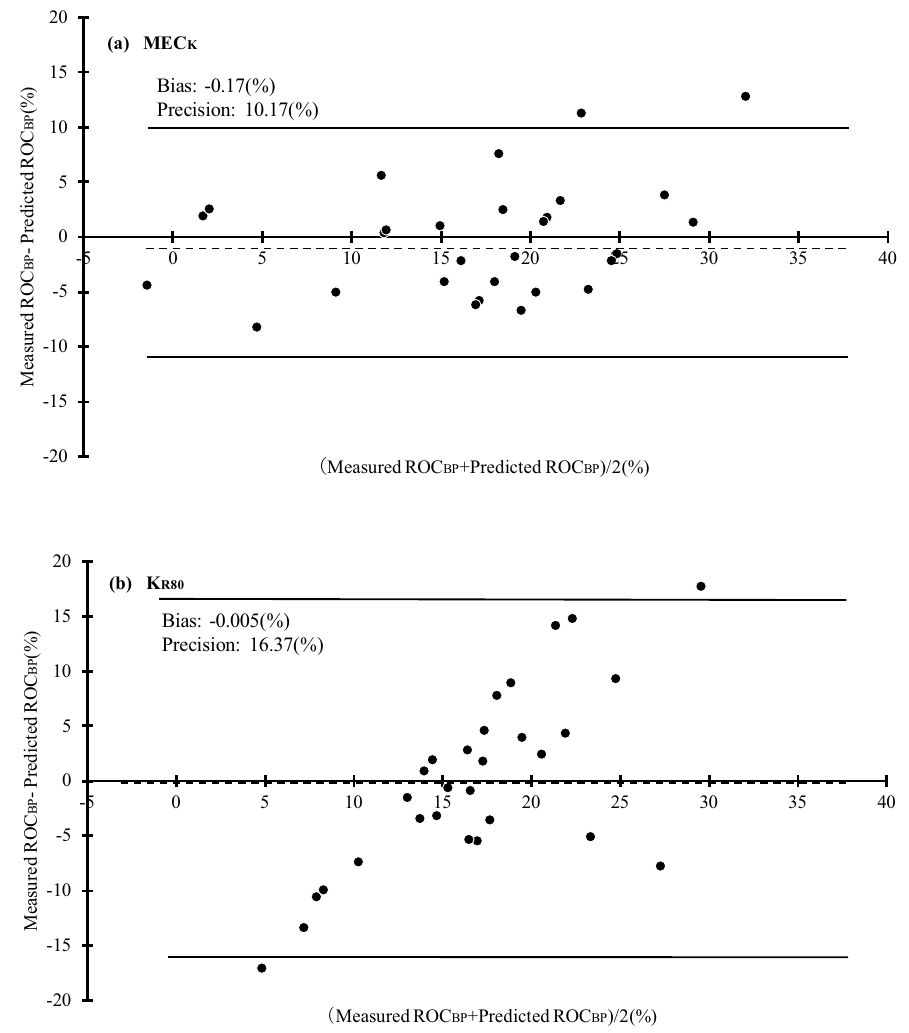
Figure 6. Comparison of the accuracy of ROC BP predictions using MEC K ( a ) and K R80 ( b ). The error associated with predicted and measured rates of change of systolic blood pressure (ROC BP ) estimated by MEC K and K R80 , respectively, are shown. The fixed bias was determined to be small since the data used to create the prediction equation, and data used for validation were the same. The proportional error of MEC K was small. K R80 displayed a definite proportional error, and its prediction performance was determined to be